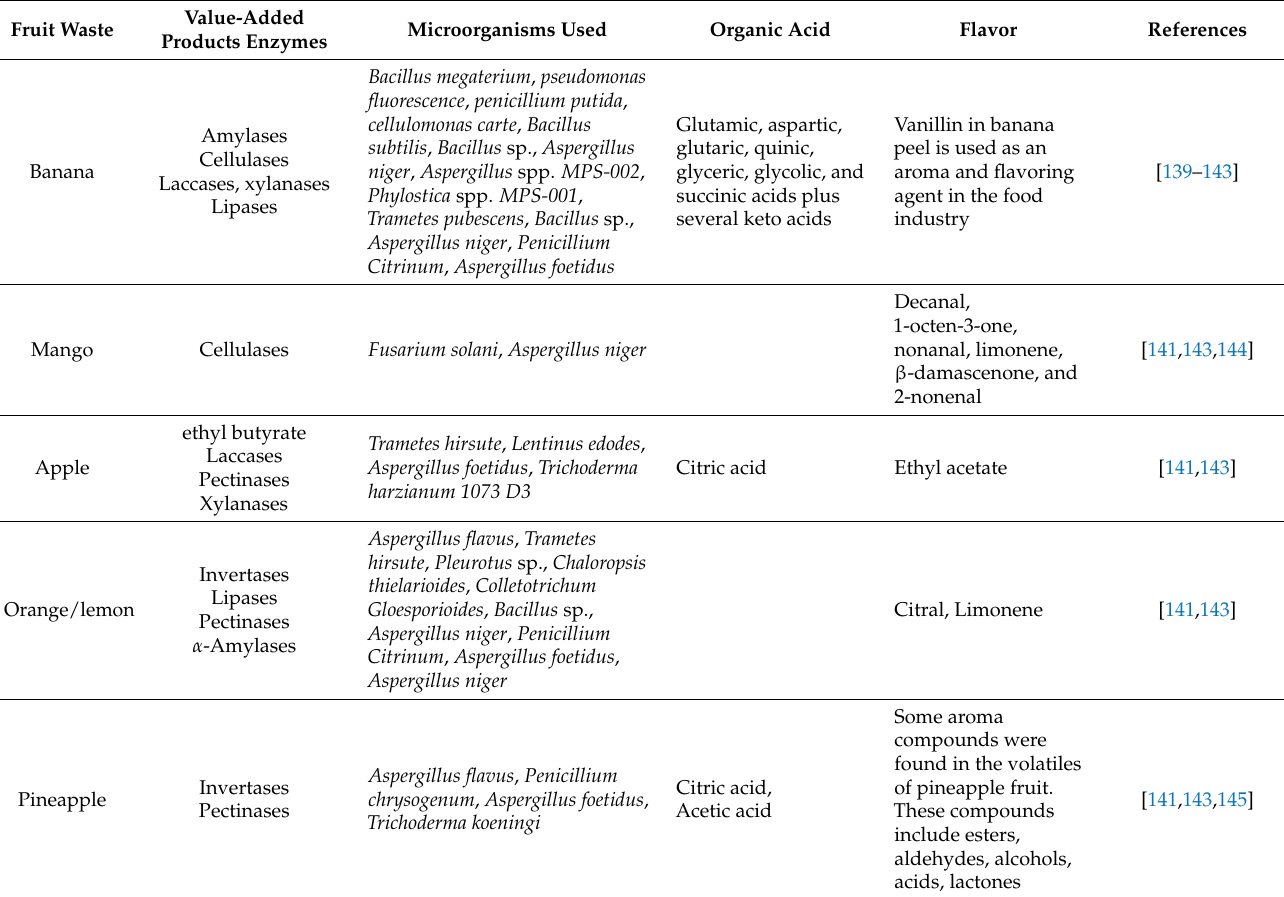
Table 4. Enzymes, organic acids, and flavor in different fruit waste